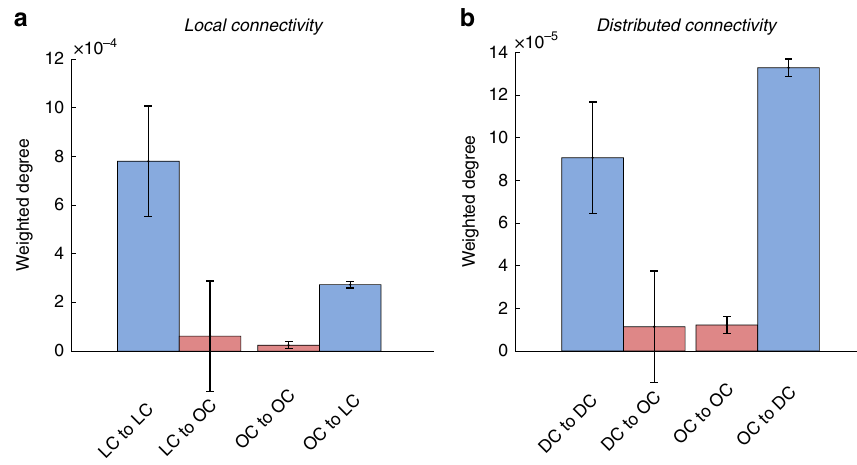
Fig. 4 Description of dynamic trajectories of paths from cortical areas discovered as local and distributed connectivity cores during task performances. Masks from cortical areas with predominant (Fig. 3c; blue/magenta in cortical masks) and non-predominant (Fig. 3c; none blue/magenta colors in cortical masks) local ( a ) and distributed ( b ) connectivity were used to obtain the amount of dynamic trajectories that remain inside or leave outside these connectivity cores in an independent sample of individuals. “ LC to LC ” and “ DC to DC ” refers to connectivity trajectories that start and end within the predominant/core areas of local and distributed connectivity. “ LC to OS ” and “ DC to OS ” refers to connectivity trajectories that start in the predominant/ core areas but end outside (OS) them. “ OS to LC ” and “ OS to DC ” refers to connectivity trajectories that start outside the predominant/core areas but end inside them. Error bars represent standard error. The y -axes represent the weighted degree of local or distributed paths (normalized by the size of